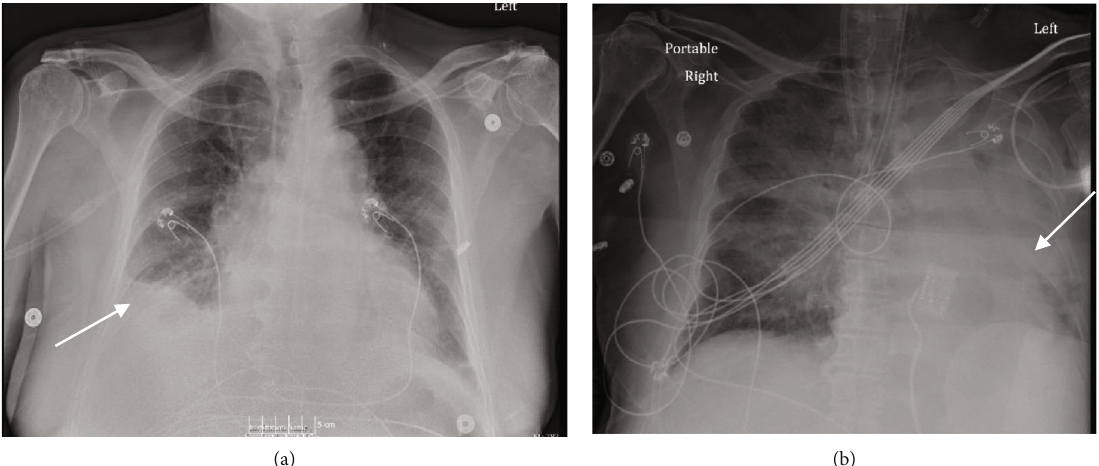
Figure 1: (a) Chest radiograph showing small right pleural e ff usion on admission. (b) Chest radiograph post-CPR showing large left pleural e ff usion.